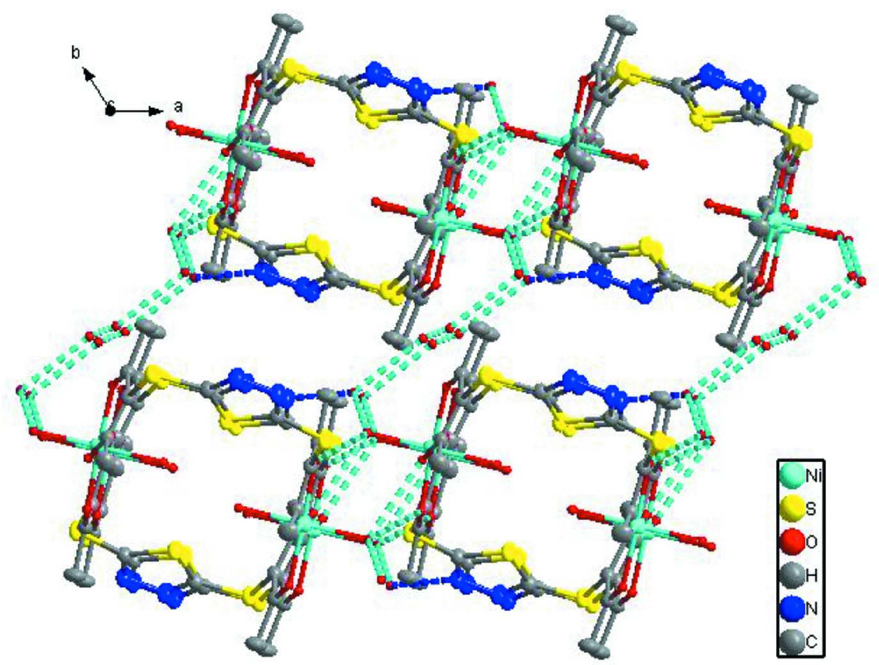
Figure 3 The three-dimensional network structures formed via hydrogen bonds along a-directions. The blue lines for O3W— H1W3..N2, For clarity, the solvent molecules of DMF and H atoms are not shown. bis{ µ -3,3 ′ -(1,3,4-thiadiazole-2,5- diyldithio)bis[pentanedionato(1-)]}bis[diaquanickel(II)]